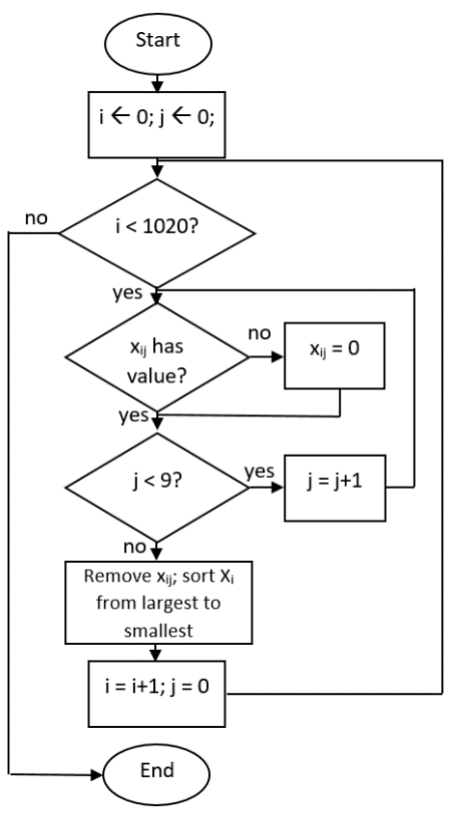
Figure 13. Preprocessing flow.